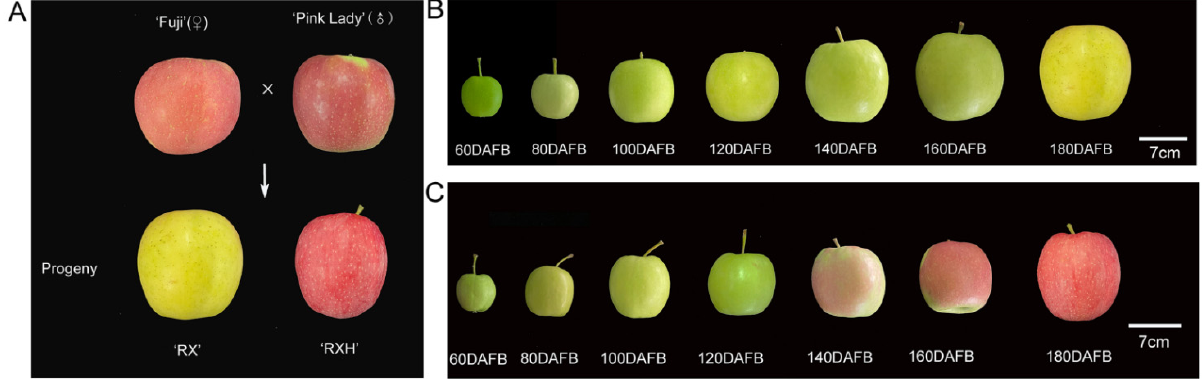
Figure 1. Appearance of different cultivars of apple in different fruit developmental stages. ( A ) Appearance of ‘Ruixue’ and ‘Ruixianghong’ and their parents apples. ( B ) Appearance of ‘Ruixue’ fruit at different development stages: 60 DAFB, 80 DAFB, 100 DAFB, 120 DAFB, 140 DAFB, 160 DAFB, and 180 DAFB. ( C ) Appearance of ‘Ruixianghong’ fruit at various development stages. DAFB: days after full bloom.